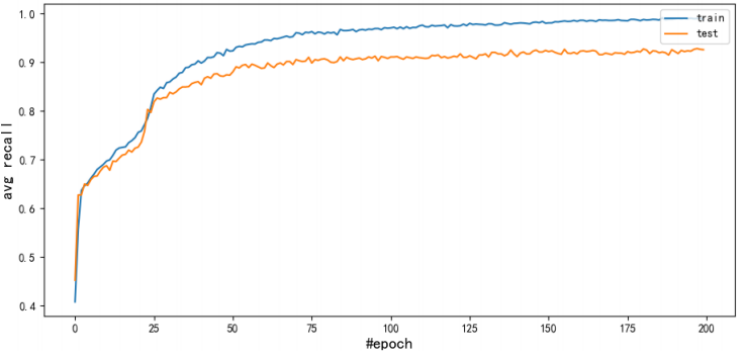
Figure 12. The change of average recall value of each label category with training epoch.